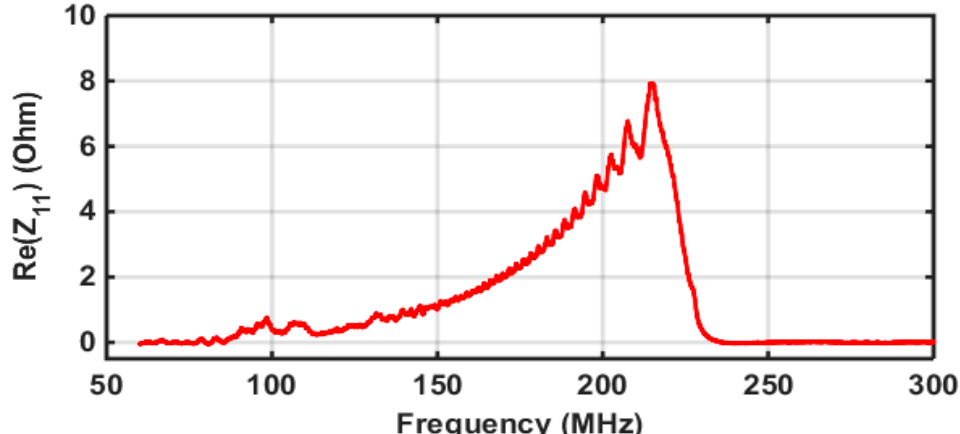
Figure 2. Electrical resistance of the chirped IDT transducer.